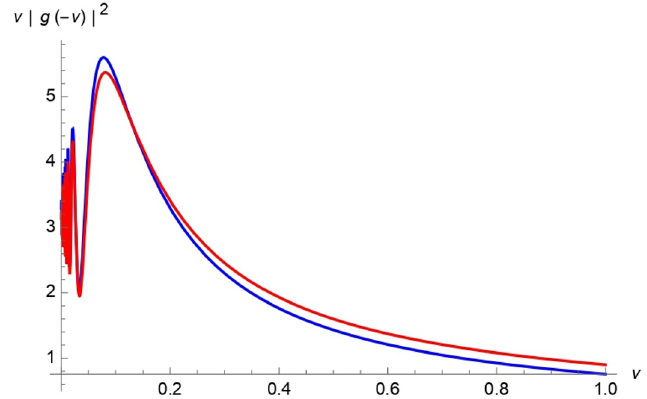
Figure 2 . Power spectrum of the field evolved from Bunch-Davies vacuum (blue graph) and from comoving vacuum (red graph) in the RD stage with k = H = 1 .